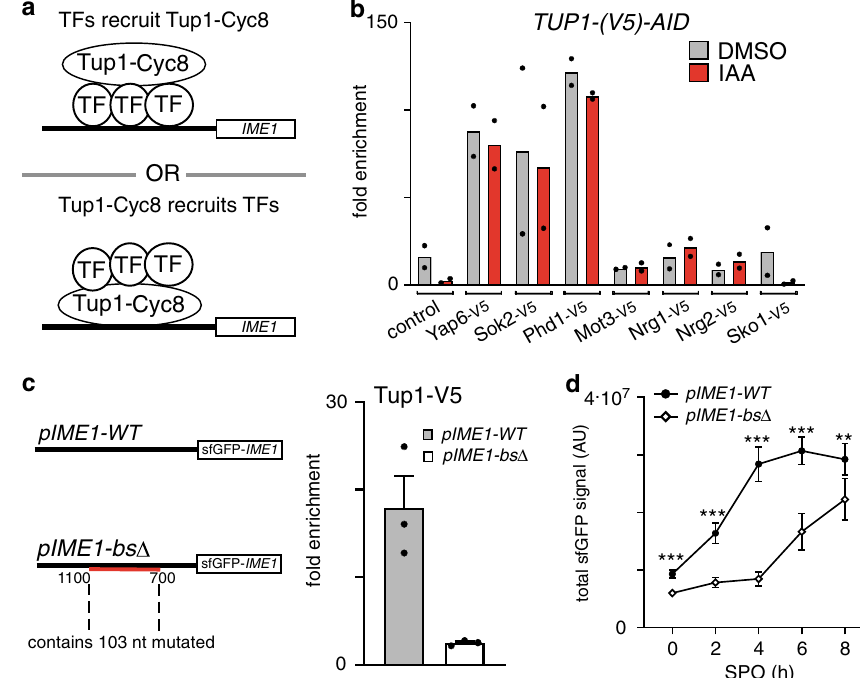
Fig. 3 Tup1 – Cyc8 is recruited by TFs associated with the IME1 promoter. a Schematic displaying how TFs and Tup1 – Cyc8 could interact at the IME1 promoter. TF = transcription factor. b Diploid cells harbouring TUP1-AID and V5-tagged TFs ( YAP6-V5 , FW4214; SOK2-V5 , FW4218; PHD1-V5 , FW5056;